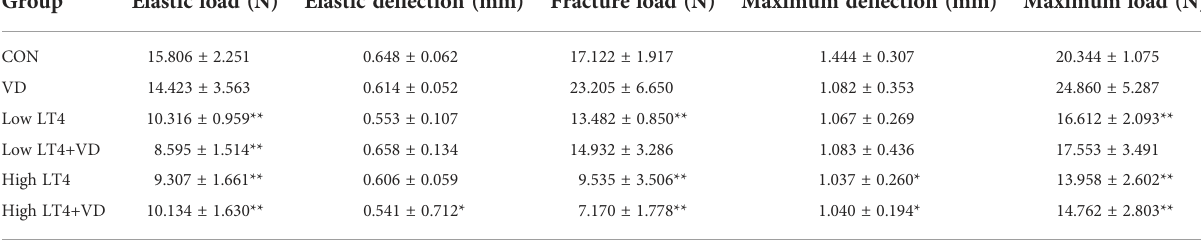
TABLE 2 Comparison of biomechanical indexes of mice in each group. Group